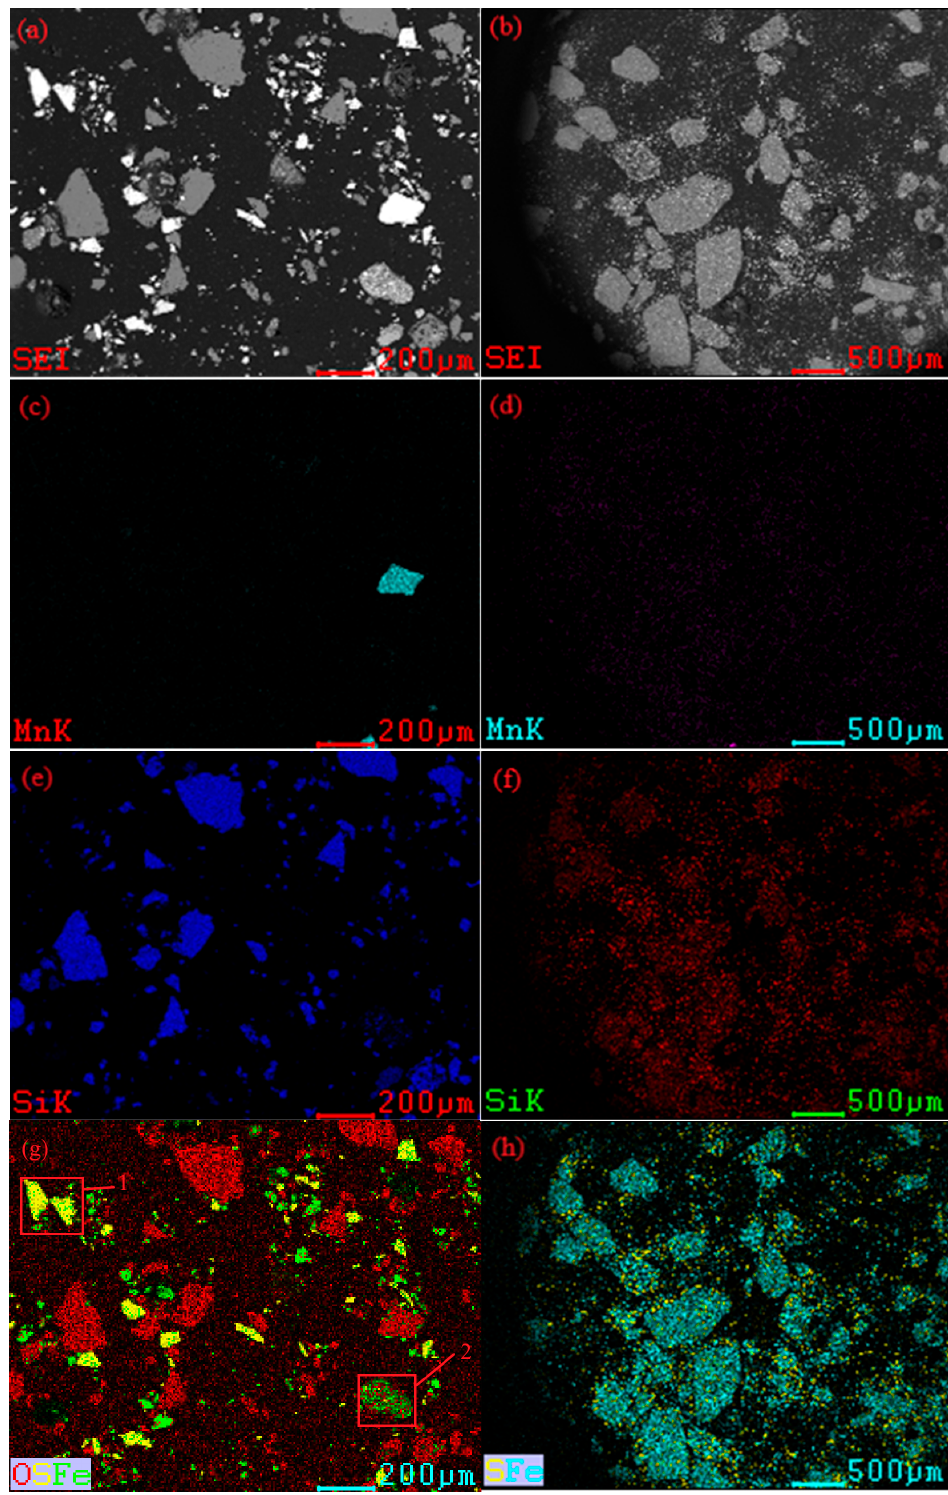
Figure 9. SEM micrographs with EDS element maps for chemical leaching residual of single factor test (amount of silver-bearing pyrite addition-level 5) ( a , c , e , g ) and two-stage leaching residual (No. 3) ( b , d , f , h ).